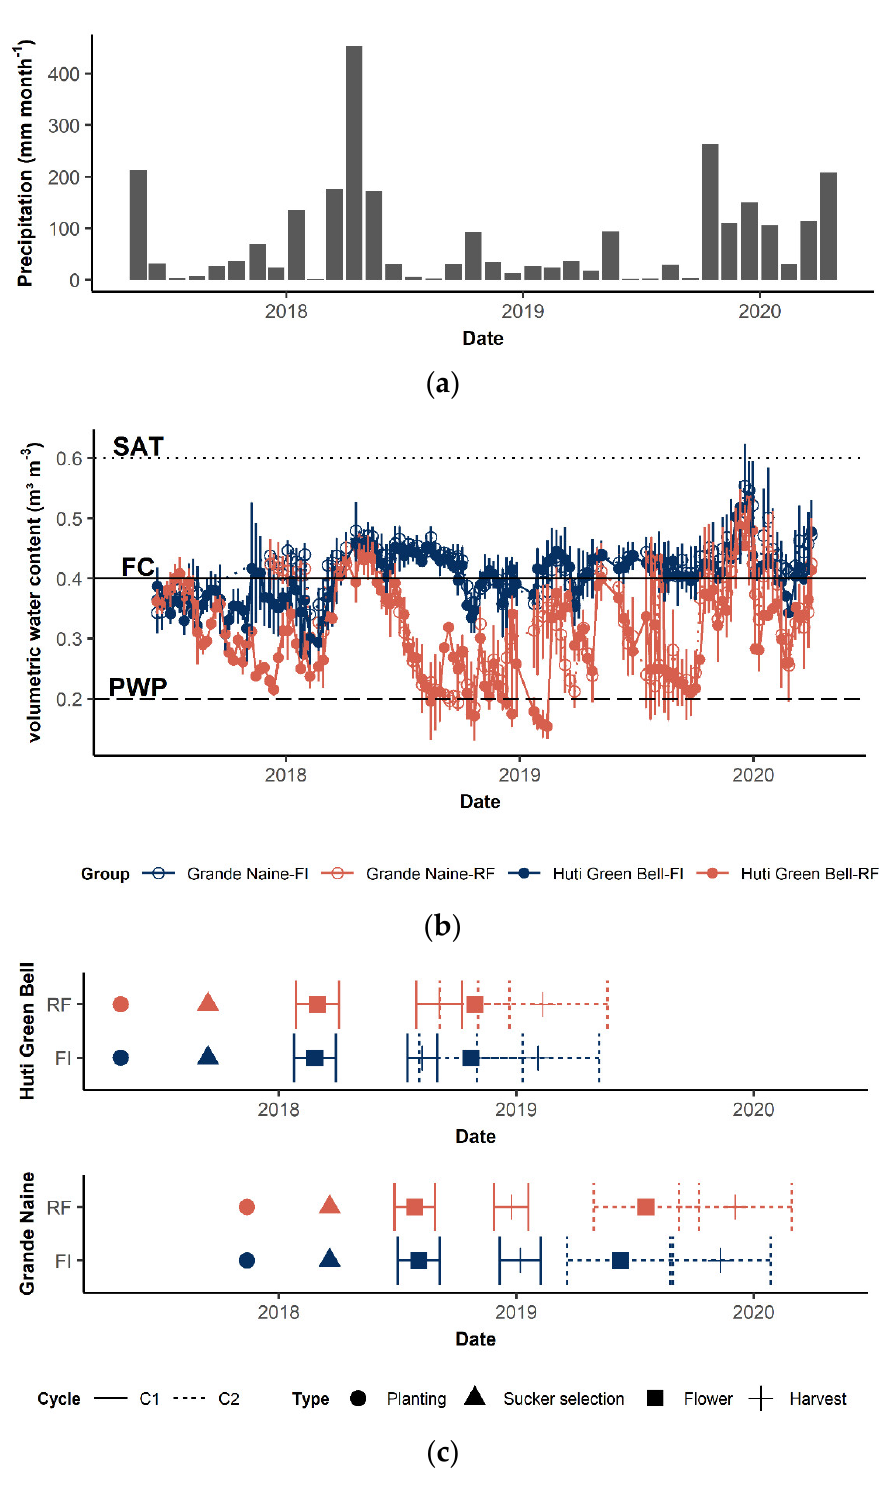
Figure 1. Water regimes in Huti Green and Grande Naine Experiments. ( a ) Precipitation (mm month −1 ) in Arusha, Tanzania over the course of the experiments; ( b ) Average weekly volumetric water content, vwc (m 3 m −3 ) in the upper 60 cm of the soil under two irrigation regimes (FI: full irrigation noted in blue, and RF: rainfed noted in orange). Error bars note mean ± standard deviation. SAT notes the vwc at saturation, FC notes the vwc at field capacity and PWP notes the vwc at permanent wilting point; ( c ) Phenological events for Huti Green Bell and Grande Naine (planting, sucker selection, flowering and harvest) for cycle 1 (C1) and cycle 2 (C2). Error bars note mean date ± standard deviation. Planting and sucker selection occurred on a single day, hence no standard deviations are present.